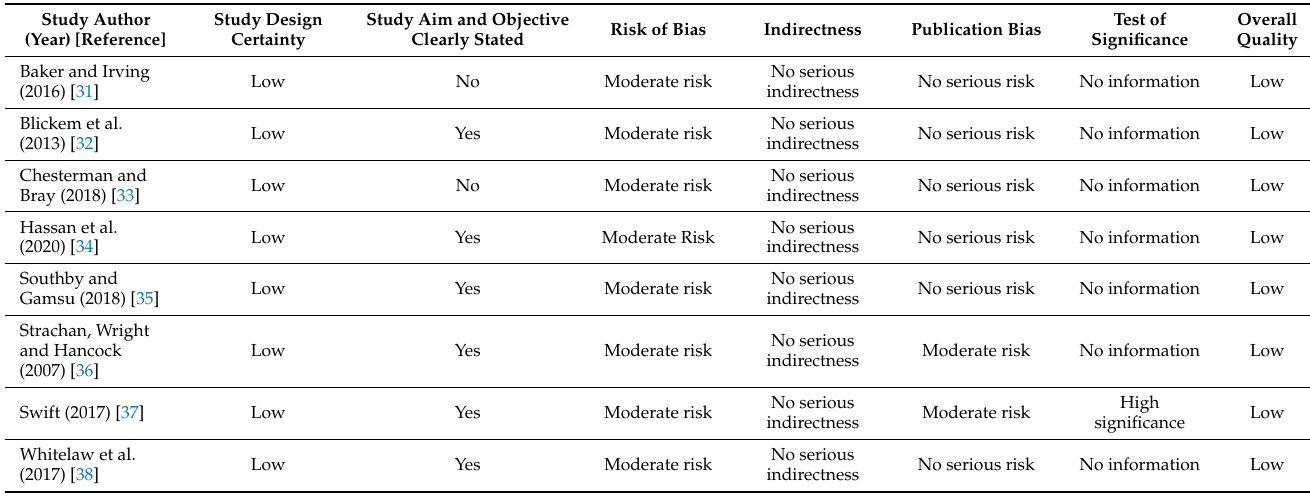
Table 1. Quality Assessment Results.